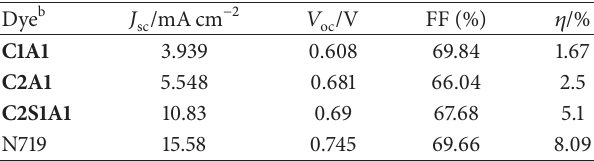
Table 2: Photovoltaic performance of dye-sensitized solar cells a